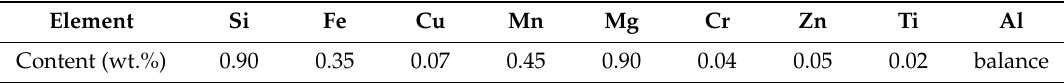
Table 1. Chemical composition of AA6082 aluminium alloy as specified by the supplier. Element Si Content (wt.%)